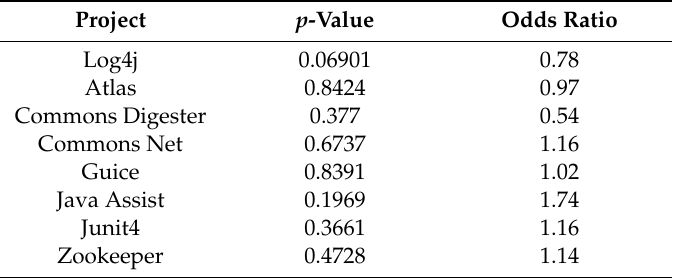
Table 8. Proportion of refactorings involving smell-a ff ected code and other code: Fisher’s exact test